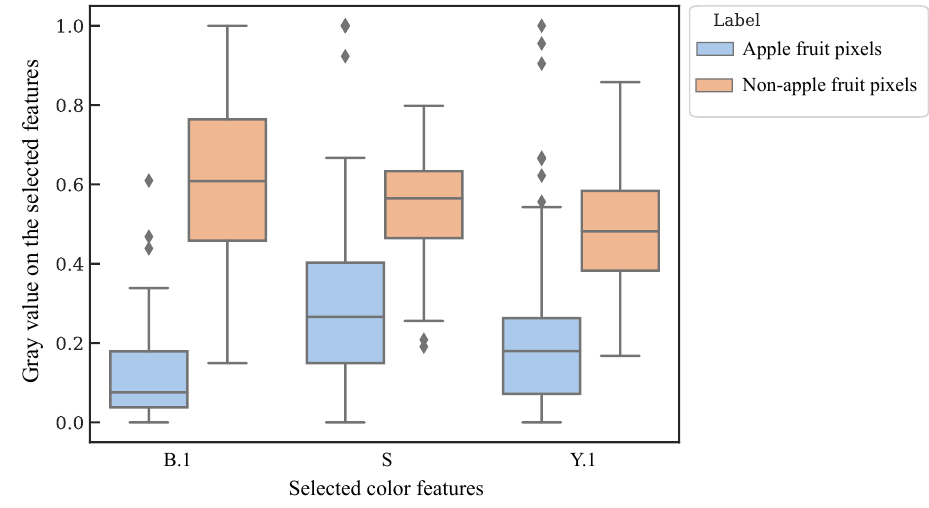
Figure 5. Boxplot of selected color